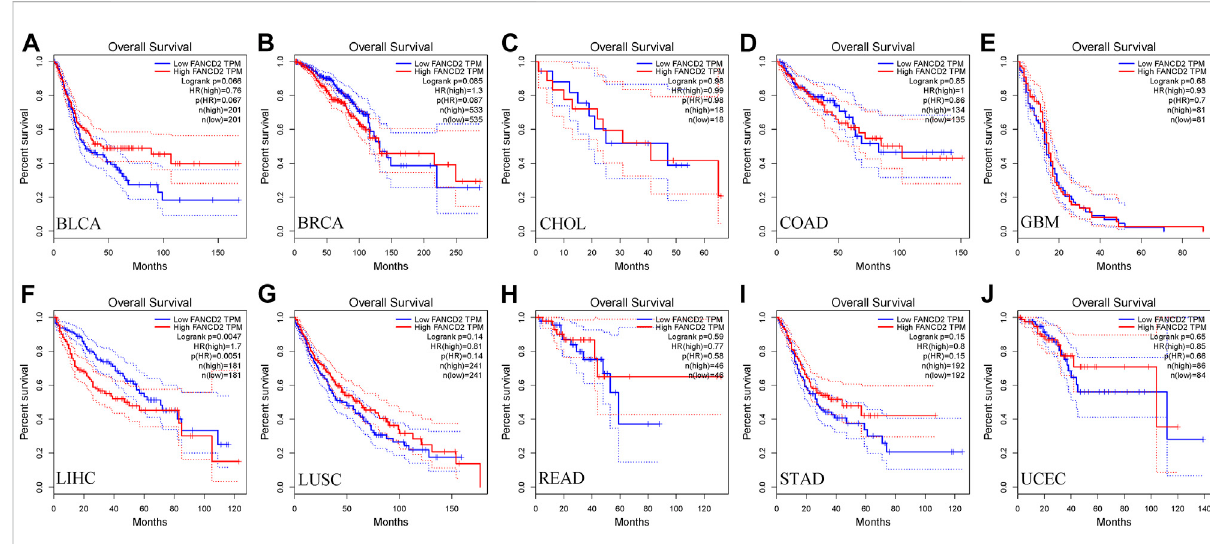
FIGURE 3 Correlation of FANCD2 expression with patient OS. (A – J) K-M method showed that high expression of FANCD2A was closely correlated with shorter lifetimes in BLCA, BRCA, CHOL, COAD, GBM, LIHC, LUSC, READ, STAD, and